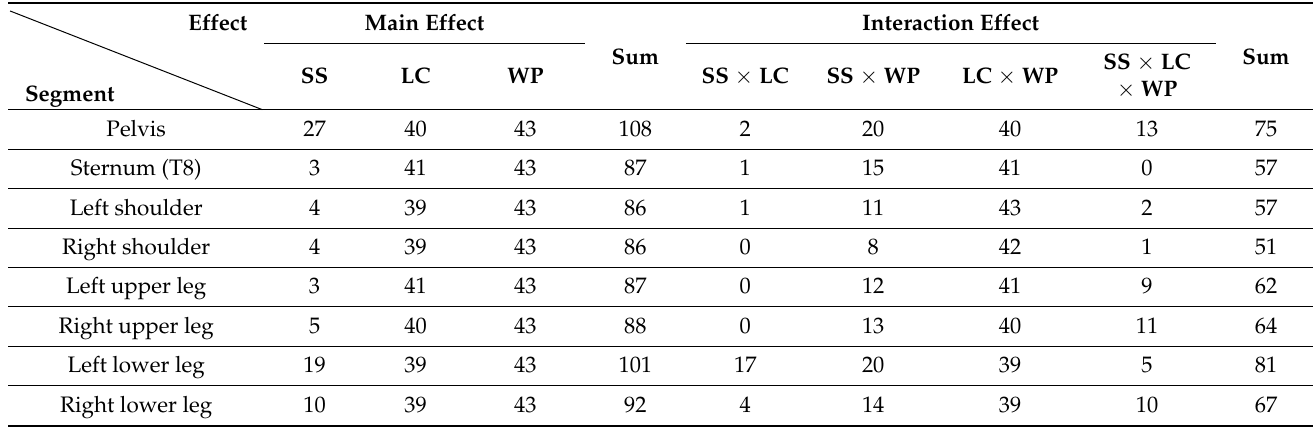
Table 4. The numbers of ACC-based measures with the abilities of factors’ effects detection.